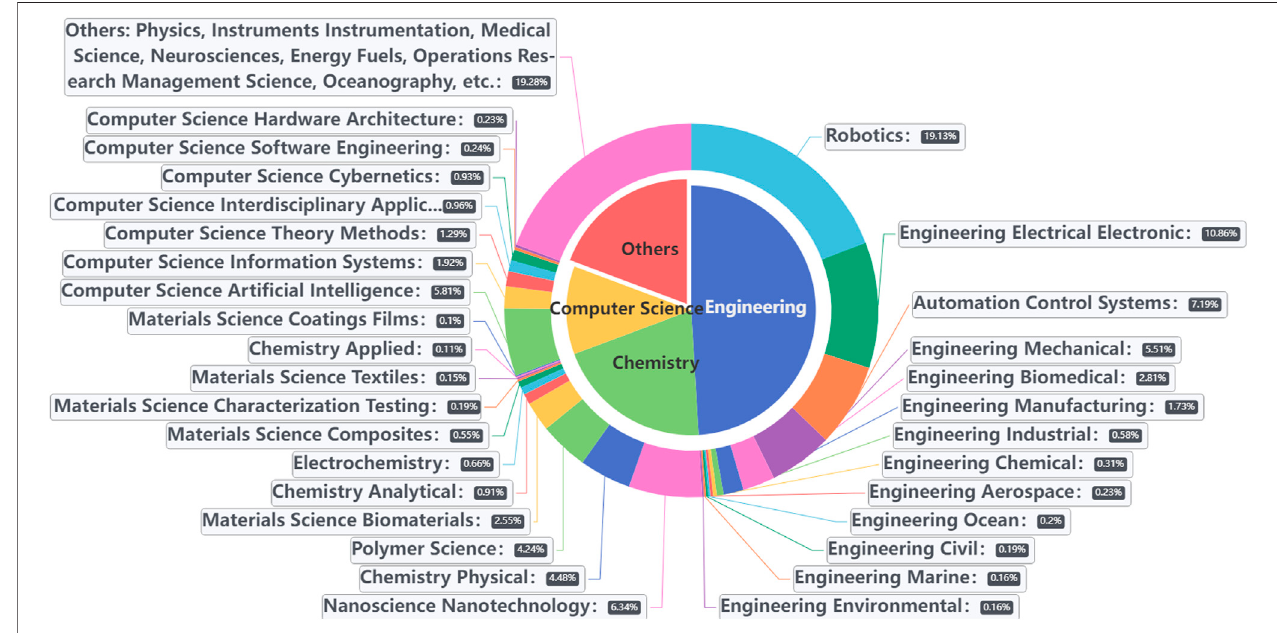
FIGURE 3 | Subject areas and their proportions in soft